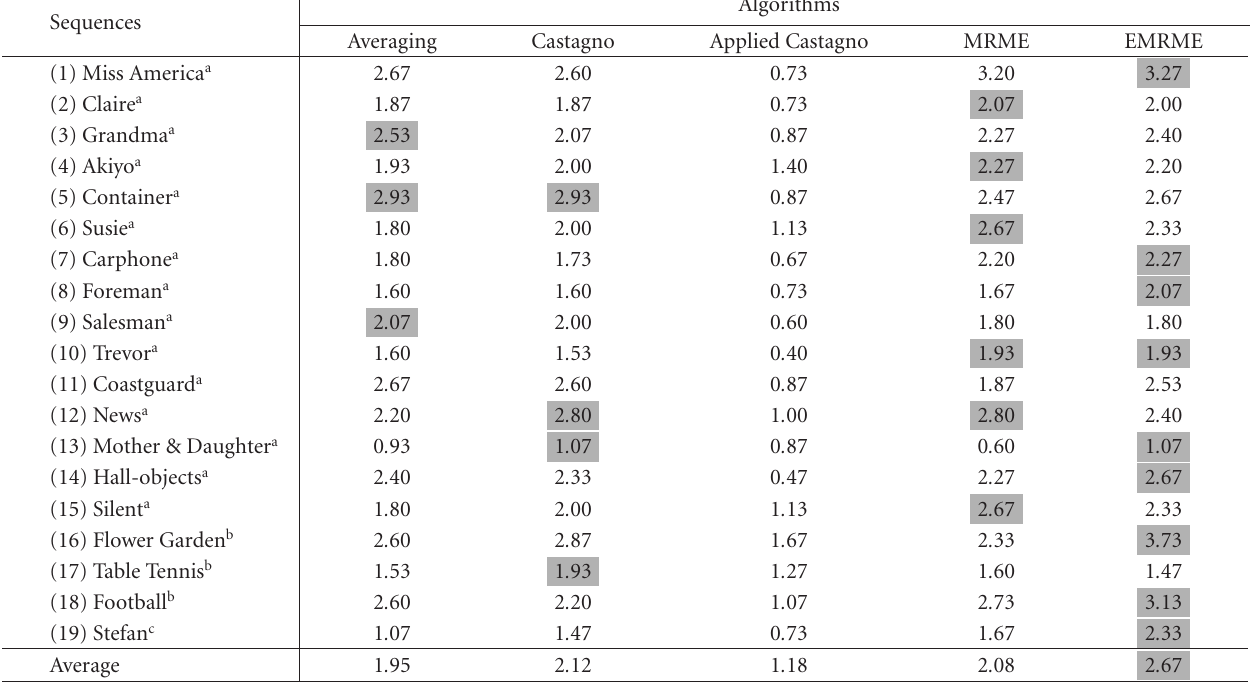
Table 3: Subjective evaluation.